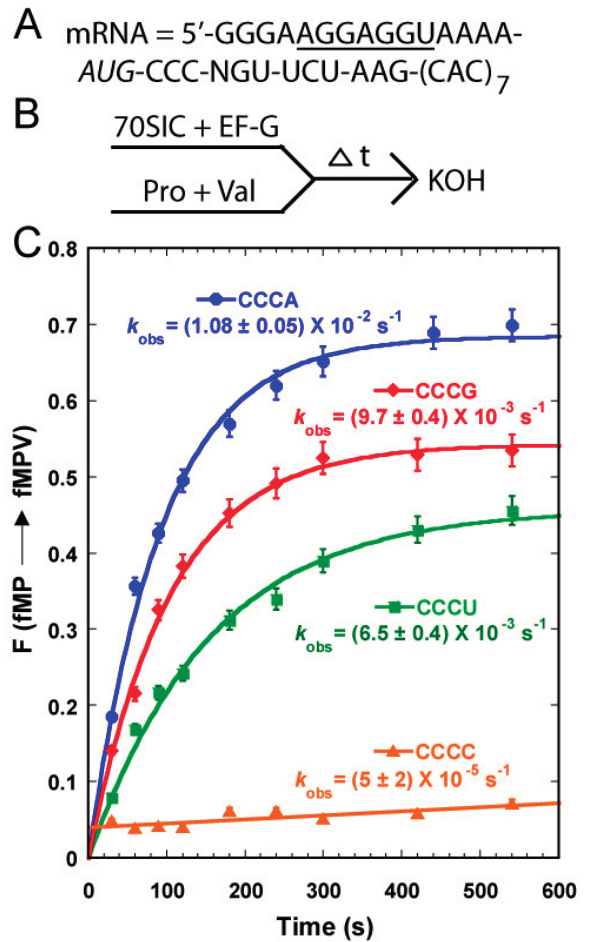
Figure 4. The propensity of shifting into the +1-frame of the native-state UGG isoacceptor of tRNA Pro on mRNA CCC-N sequences. ( A ) The template mRNA sequences, showing the 5 ʹ -Shine Dalgarno sequence (underlined), the AUG start codon (italic), and the slippery CCC-N sequence immediately following the start codon, where N = A, C, G, and U; ( B ) The reaction scheme for monitoring +1FS by rapid mixing of a 70SIC with ternary complexes of tRNA Pro and tRNA Val in the presence of EF-G; and ( C ) Kinetics of the fractional conversion (F) from fMP to fMPV was monitored over time. The k obs for each mRNA sequence was indicated and each data point is the average of 3 independent